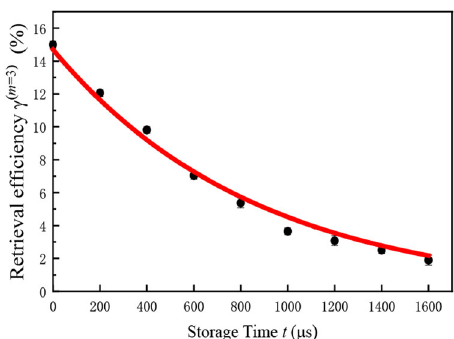
Fig. 2 Retrieval ef fi ciency of the multiplexed QM (quantum memory) as a function of t. Black circles are the experimental data of the measured retrieval ef fi ciency of the MQI (multiplexed quantum interface) based on storages of the three SW (spin wave) qubits. Red line is the linear best fi ts e (cid:2) t = τ 0 . The errors of the experimental data based on γ ð m ¼ 3 Þ ð t Þ ¼ γ 0 associated with the data correspond to one standard deviation of the measured value and are smaller than the data points